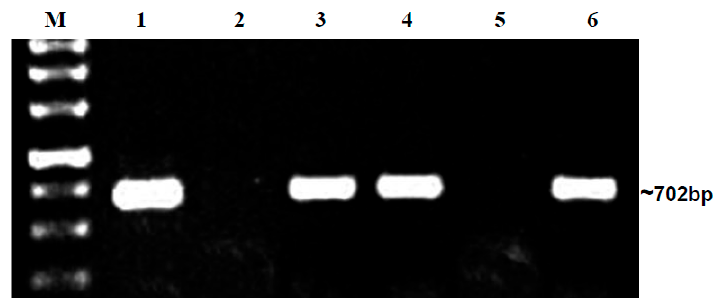
Figure 3. Detection of ToLCNDV in DAS-ELISA-positive embryo samples of H2 seeds from field- collected seeds. M—1 Kb Ladder, L1–L5—H2 Embryo samples; L6—PC.